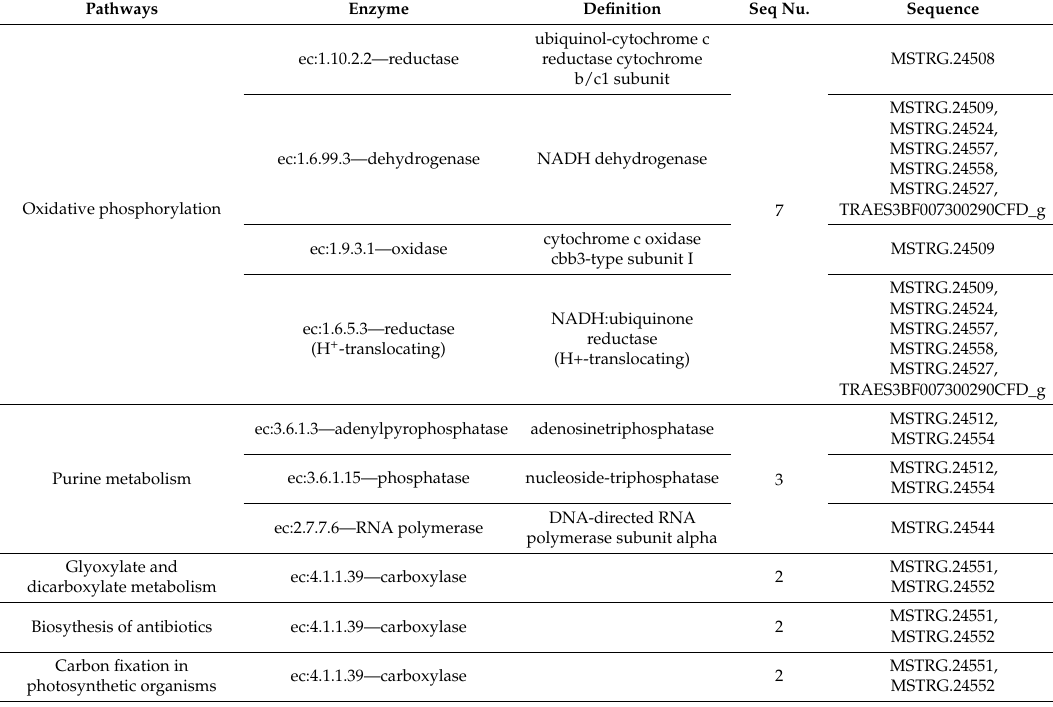
Table 2. Pathways associated with the 13 genes in the gene island at region 181.40–181.54 Mb of wheat chromosome